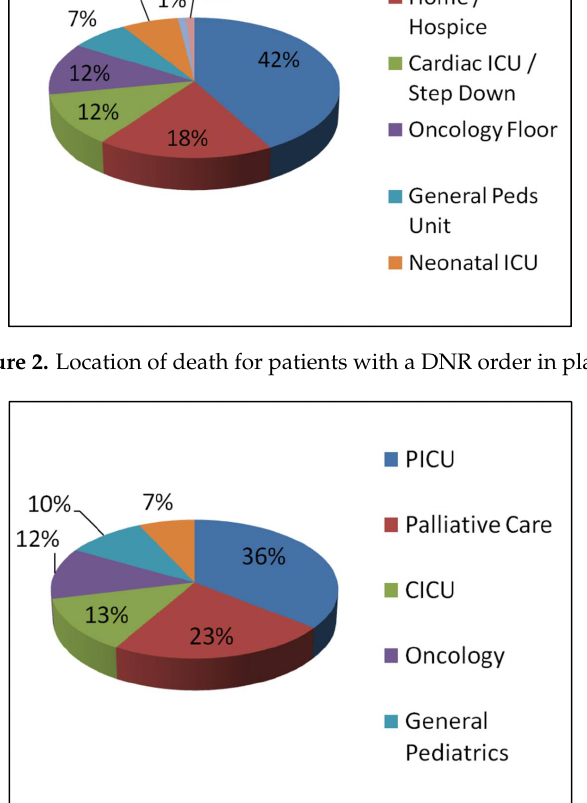
Figure 3. Specialty of physician obtaining the DNR order. Children 2018 , 5 , x FOR PEER REVIEW